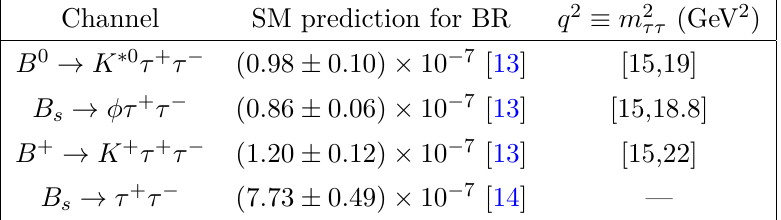
— = 3 . 686 GeV) on ψ (2 S )